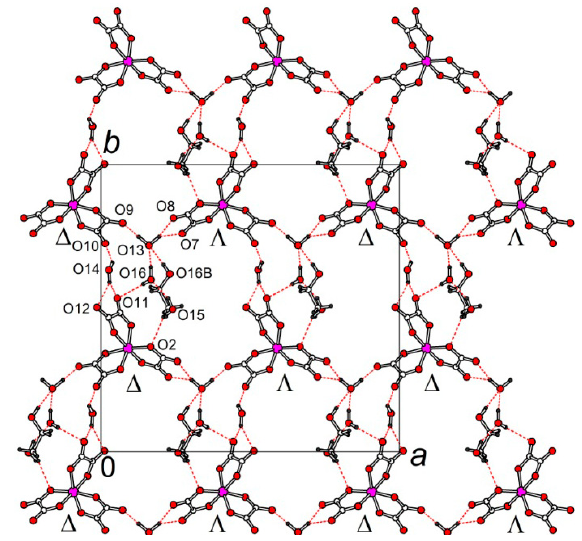
Figure 7. The anion layer in 5 . O-H…O hydrogen bonds are shown by red dashed lines. Right-handed Δ and left-handed Λ isomers of the chiral anion alternate along the a direction. Water molecules O(13) connect the different enantiomers of the anion along a and O(14) join similar enantiomers along b , resulting to a network of tilted parallelograms having Ga atoms at the vertices. Additional disordered water and ethanol molecules are located in the free cavity near one side of parallelogram and form hydrogen bonds with the anion and water molecule O(13).